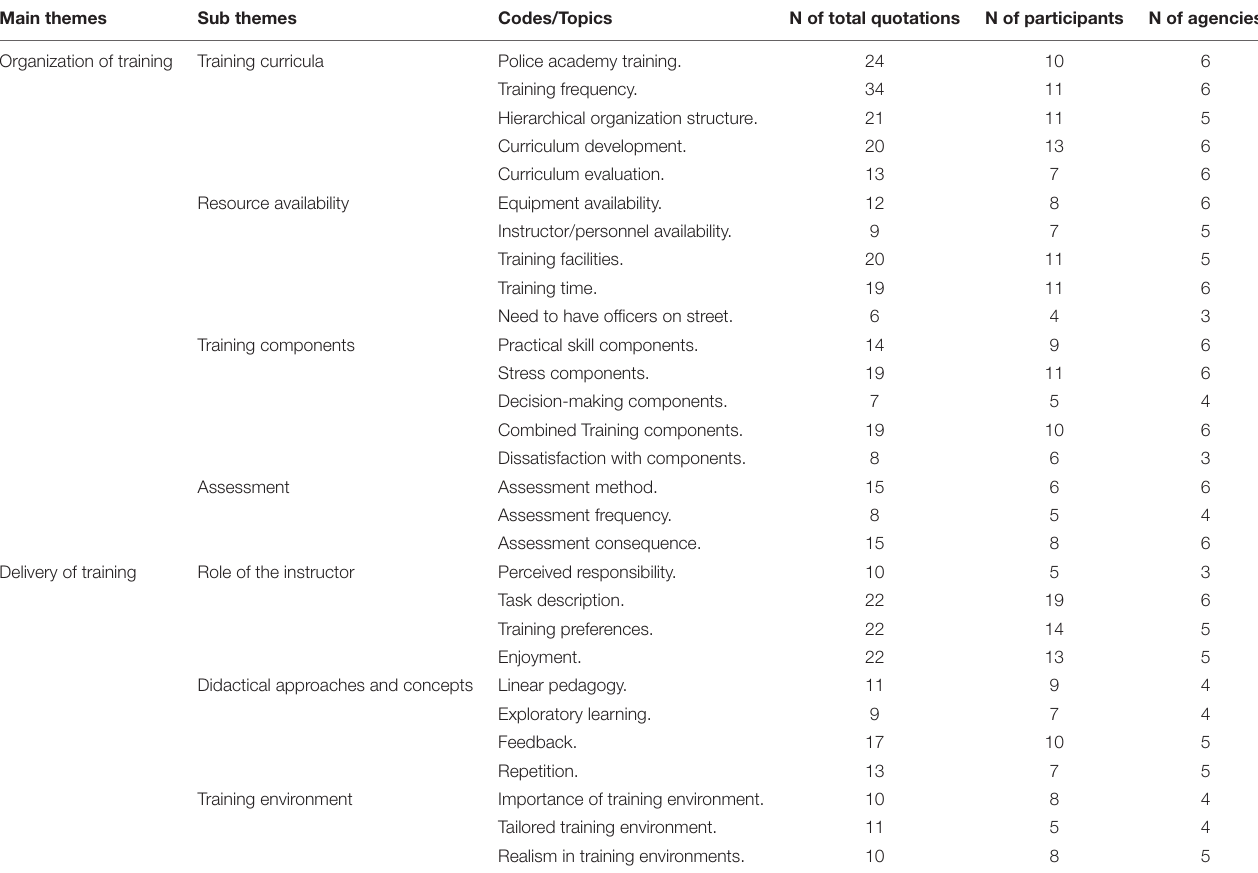
TABLE 2 | Overview of main themes, sub themes, and their corresponding